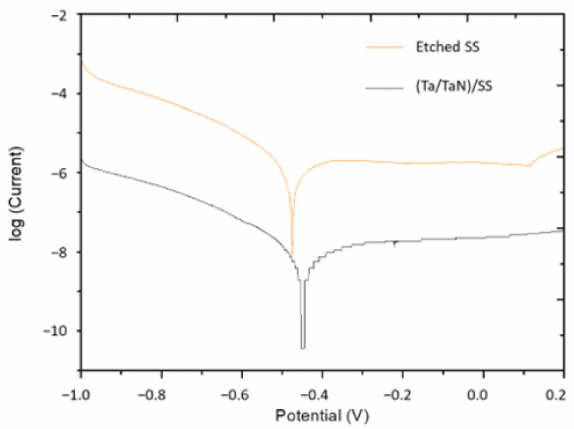
Figure 3. Polarization curves of the Bode diagram of etched SS and (Ta/TaN)/SS.